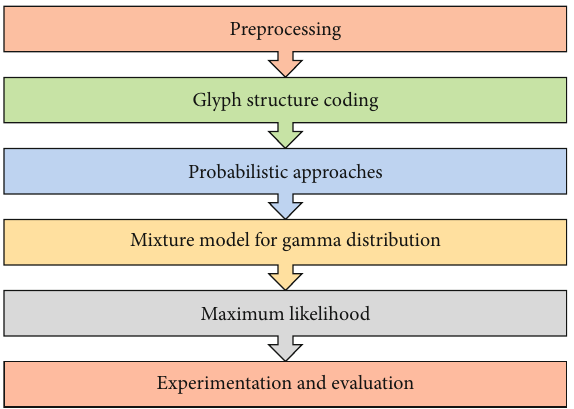
Figure 1: Flowchart of the proposed